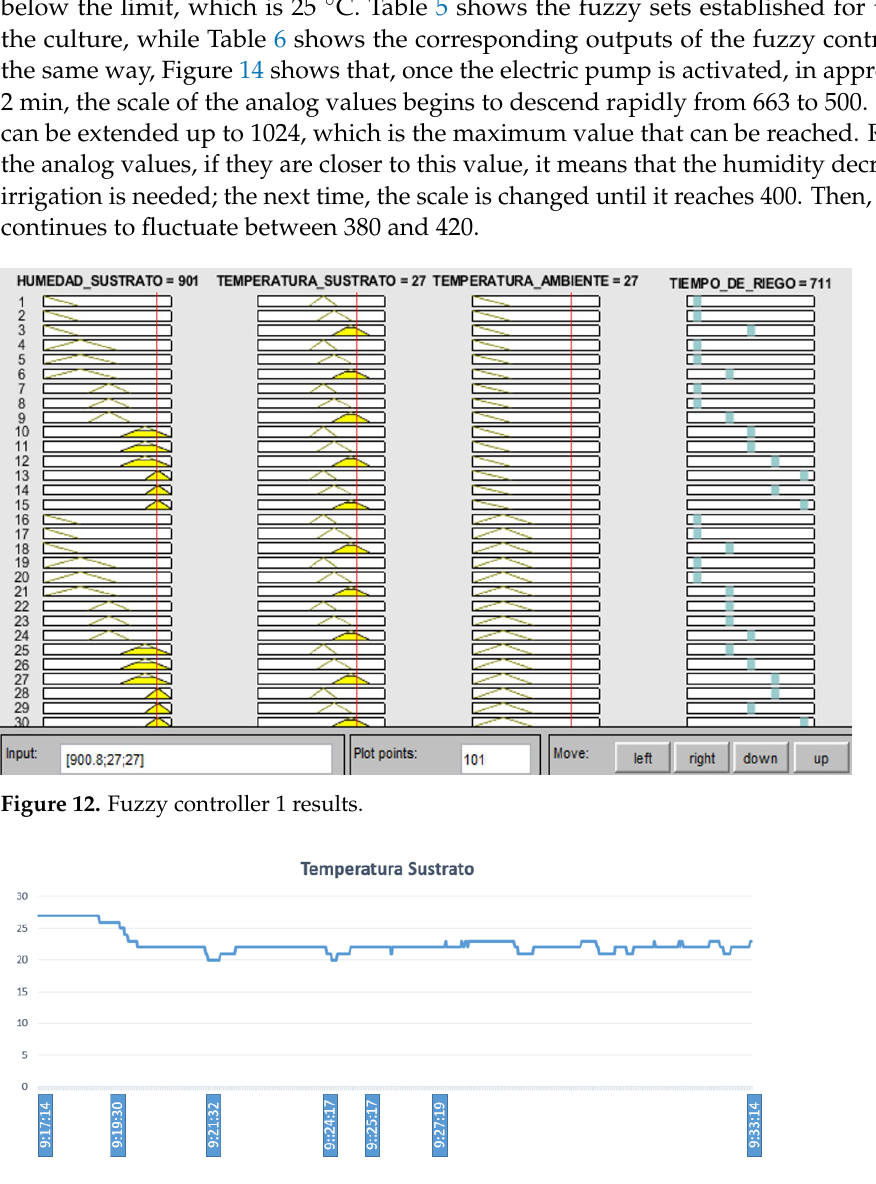
Figure 13. Substrate temperatura